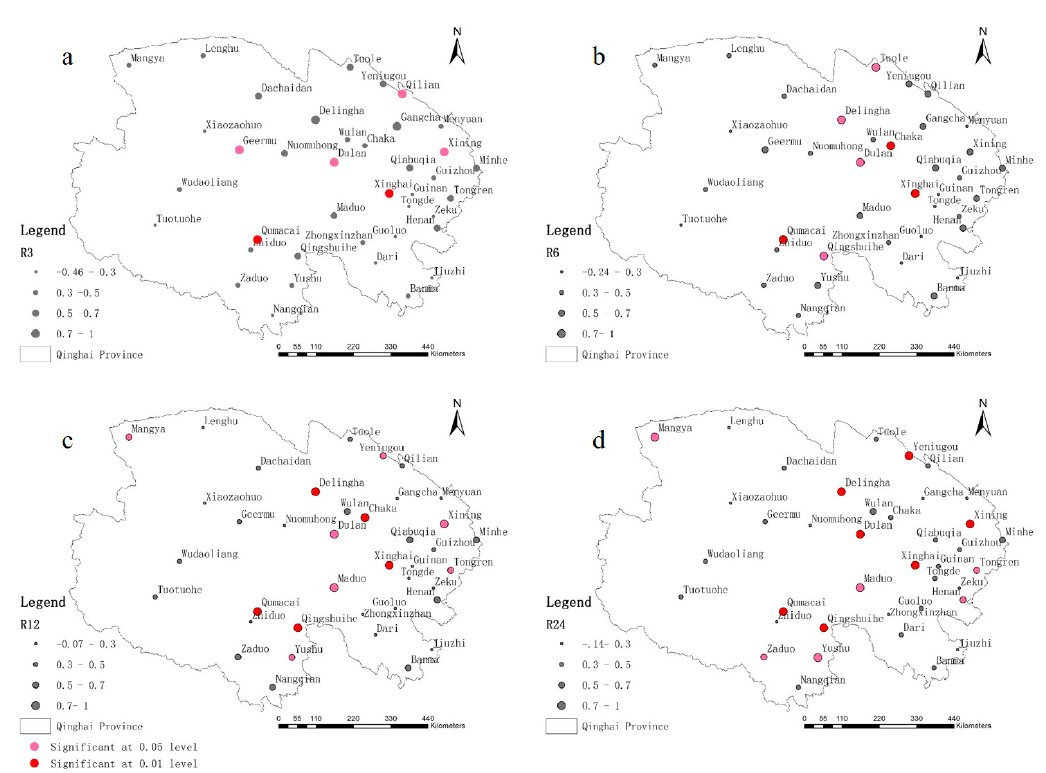
Figure 8. The correlation coefficient map of annual average NDVI and SPEI at different time scales of 39 meteorological stations. ( a ) R3, correlation with SPEI 3; ( b ) R6: correlation with SPEI 6; ( c ) R12: correlation with SPEI 12; ( d ) R24: correlation with SPEI 24.